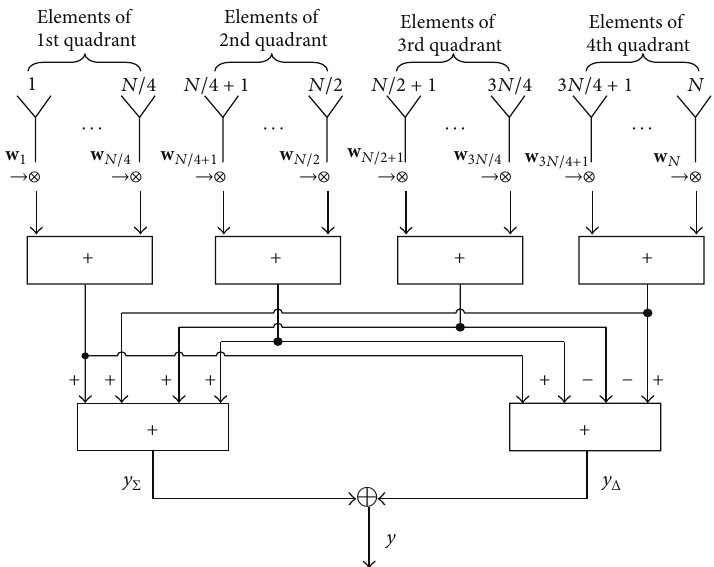
Figure 10: Construction of sum and difference channels.